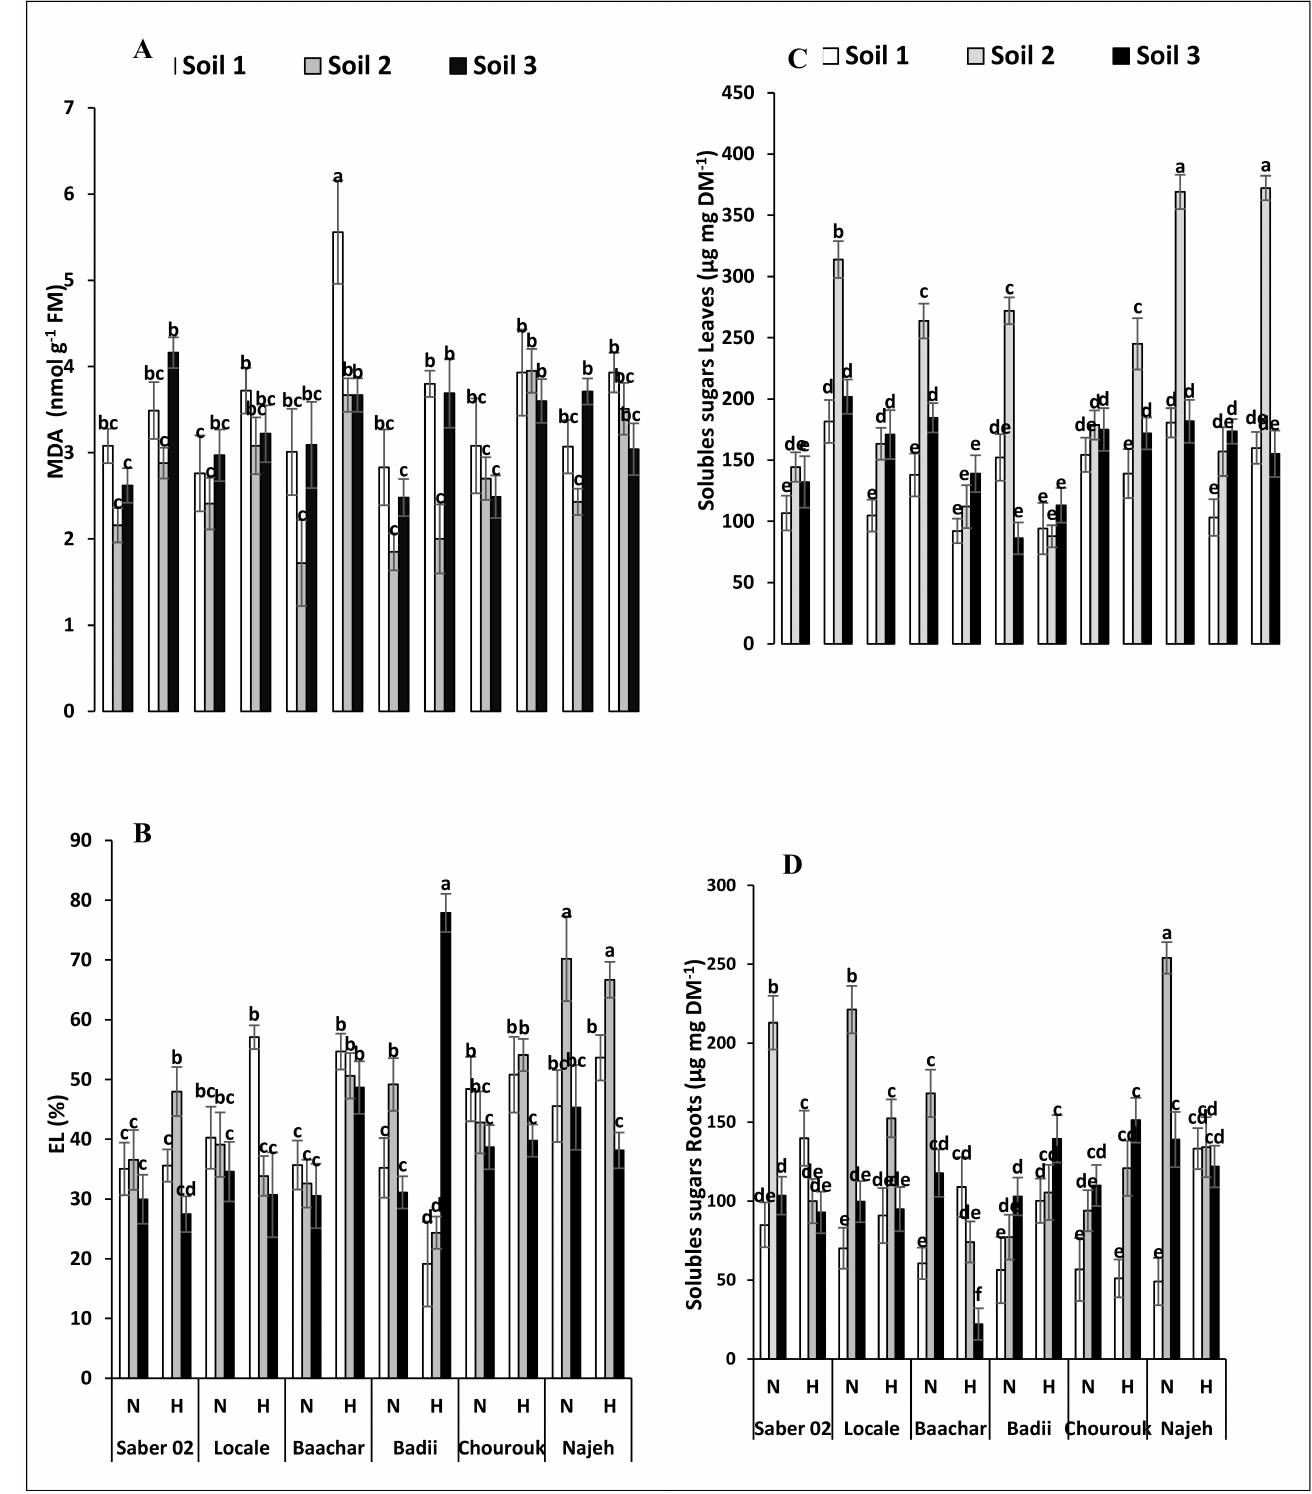
Figure 1. Effect of hypoxia and/or salinity stress on the content of MDA ( A ) and electrolyte leakage ( B ) in leaves of six Vicia faba seedling genotypes, the content of soluble sugars in leaves ( C ) and root ( D ) of six Vicia faba seedlings genotypes treated for 30 days on three different soils. Values are the means of three replications ± SE. The data followed by different letters are significantly different at p ≤ 0.05. N—Normoxia, H—Hypoxia, Soil 1—Control, Soil 2—Saline, Soil